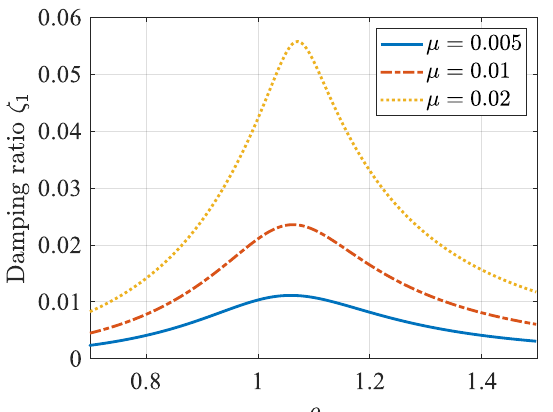
Figure 4. First modal damping of a cable with a single TM-HDR-D versus the frequency ratio 𝜌 ( 𝑥 2 /𝐿 = 0.5, 𝜑 = 0.5 ).